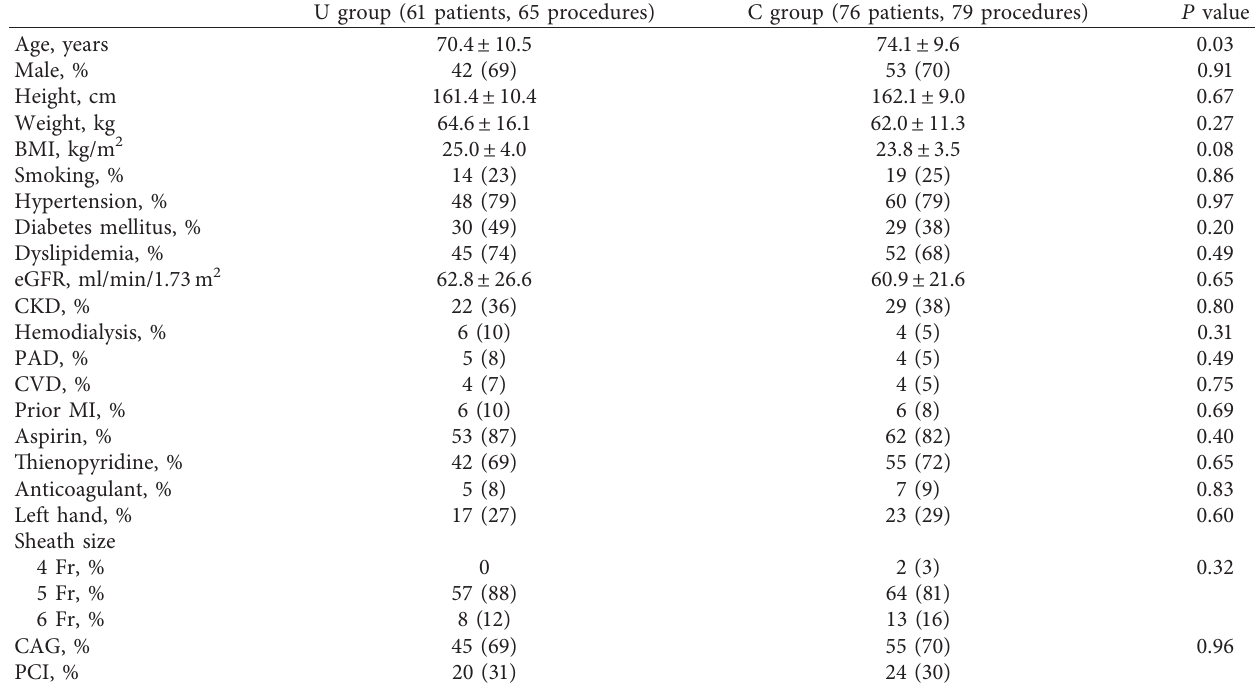
Table 1: Patient and procedural characteristics.